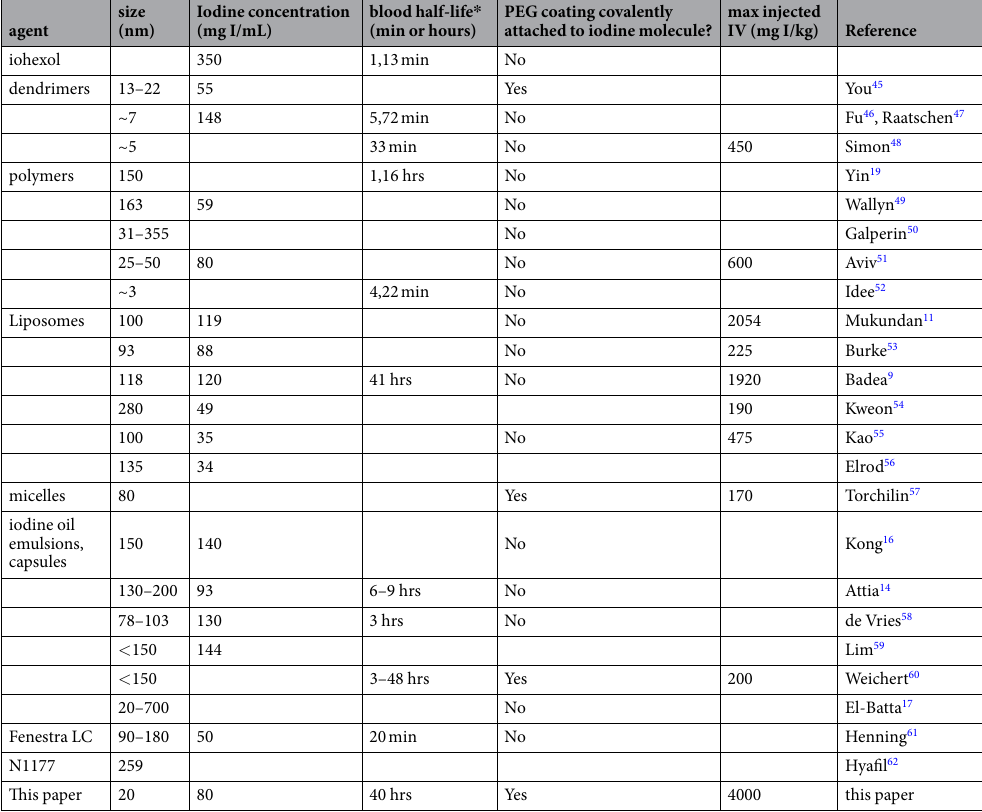
Table 1. Iodine nanoparticle comparison (empty fields were not reported). * If a short and long term half-life (2 phase) is reported, two numbers are